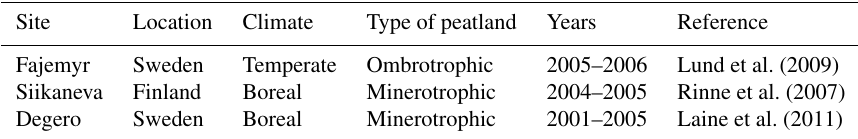
Table 2. Descriptions of peatlands sites used for site evaluation. The “Years” column corresponds to the available years of FLUXNET meteorological